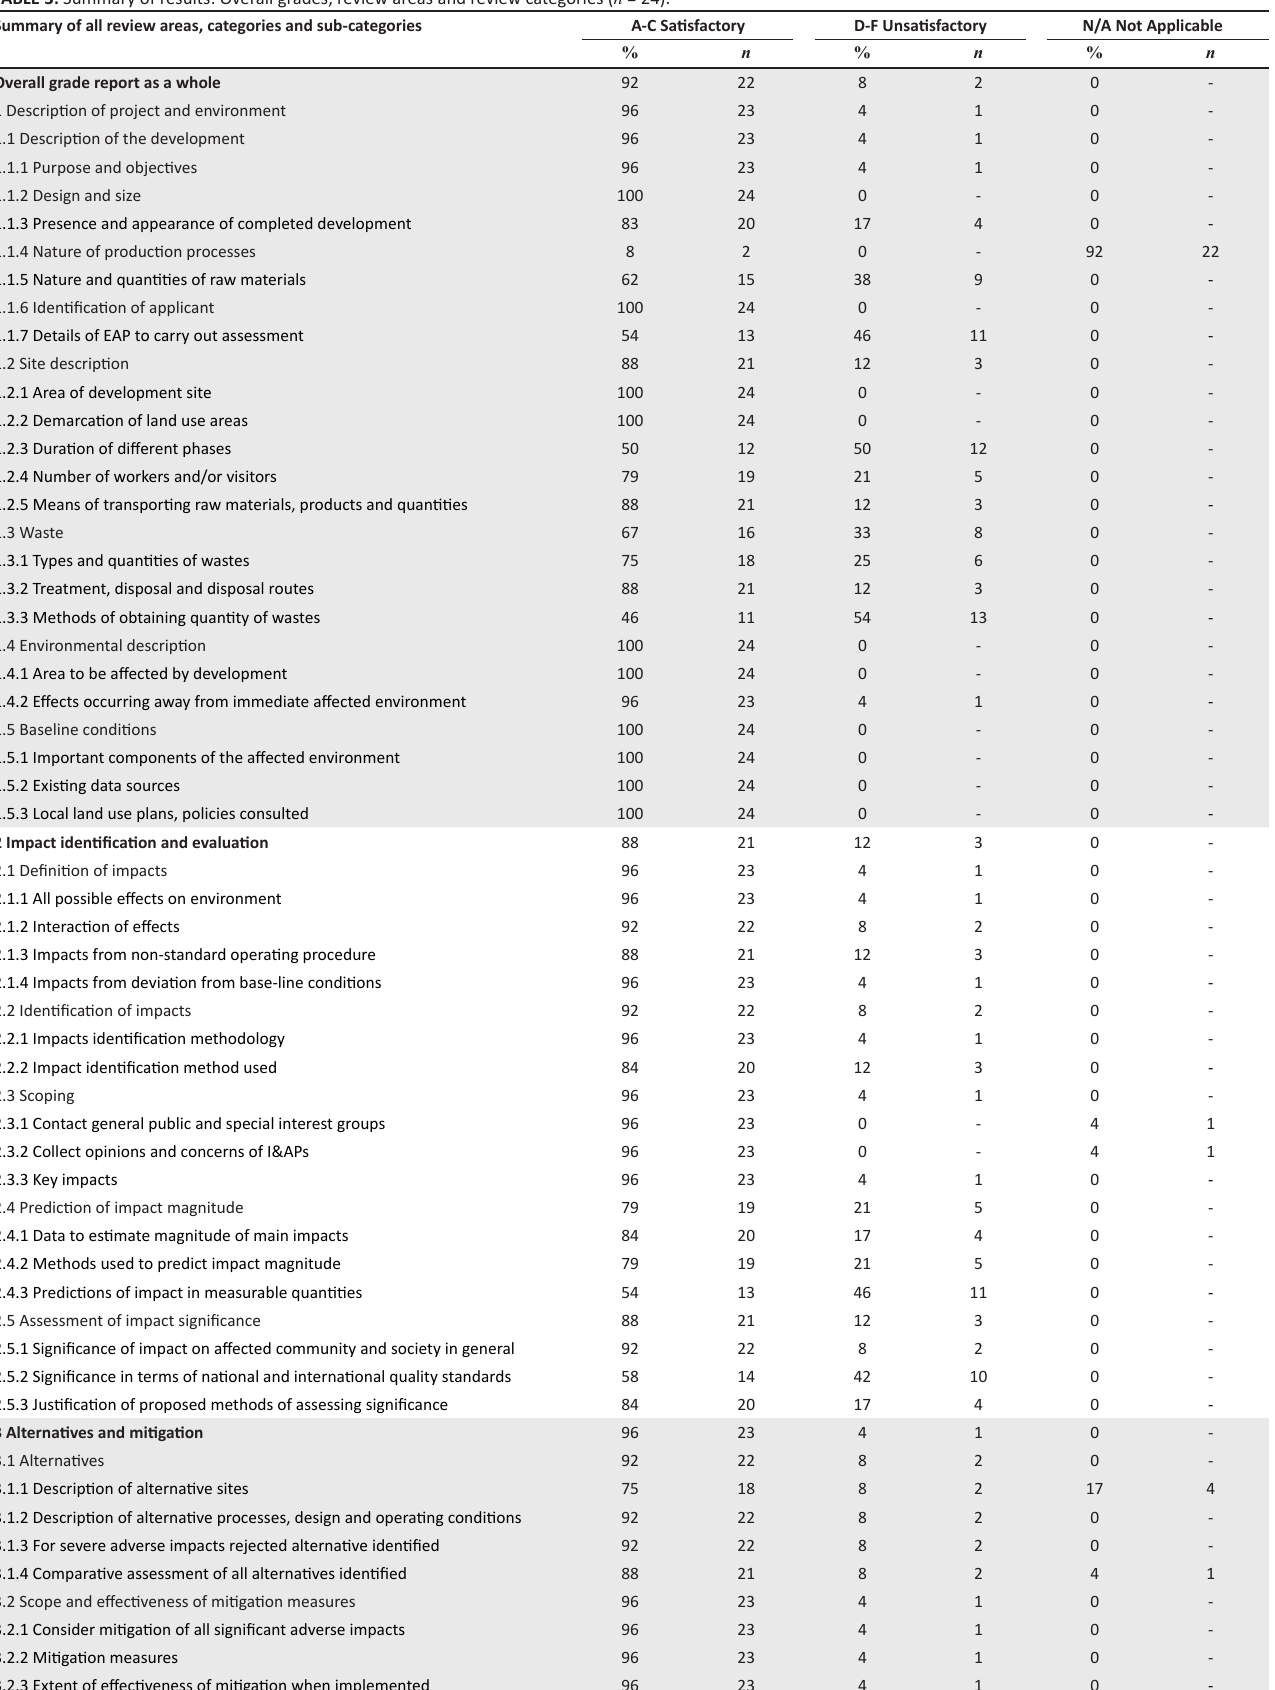
TABLE 3: Summary of results: Overall grades, review areas and review categories ( n = 24). Summary of all review areas, categories and